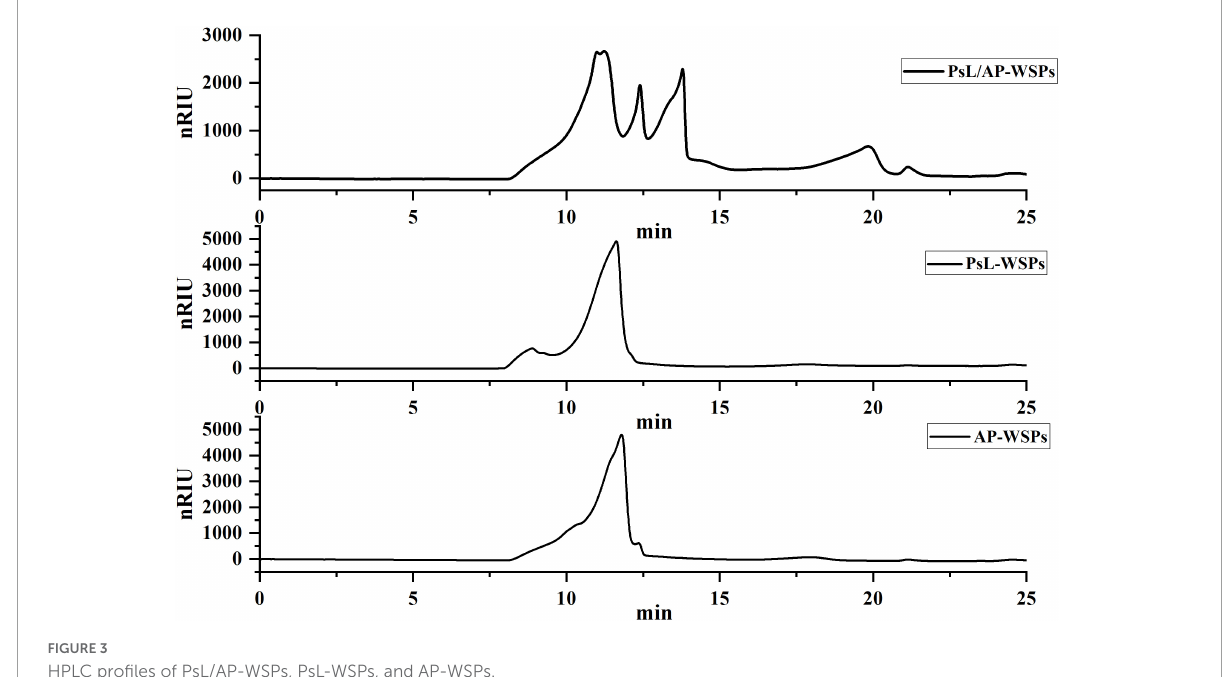
FIGURE3 HPLC profiles of PsL/AP-WSPs, PsL-WSPs, and AP-WSPs.